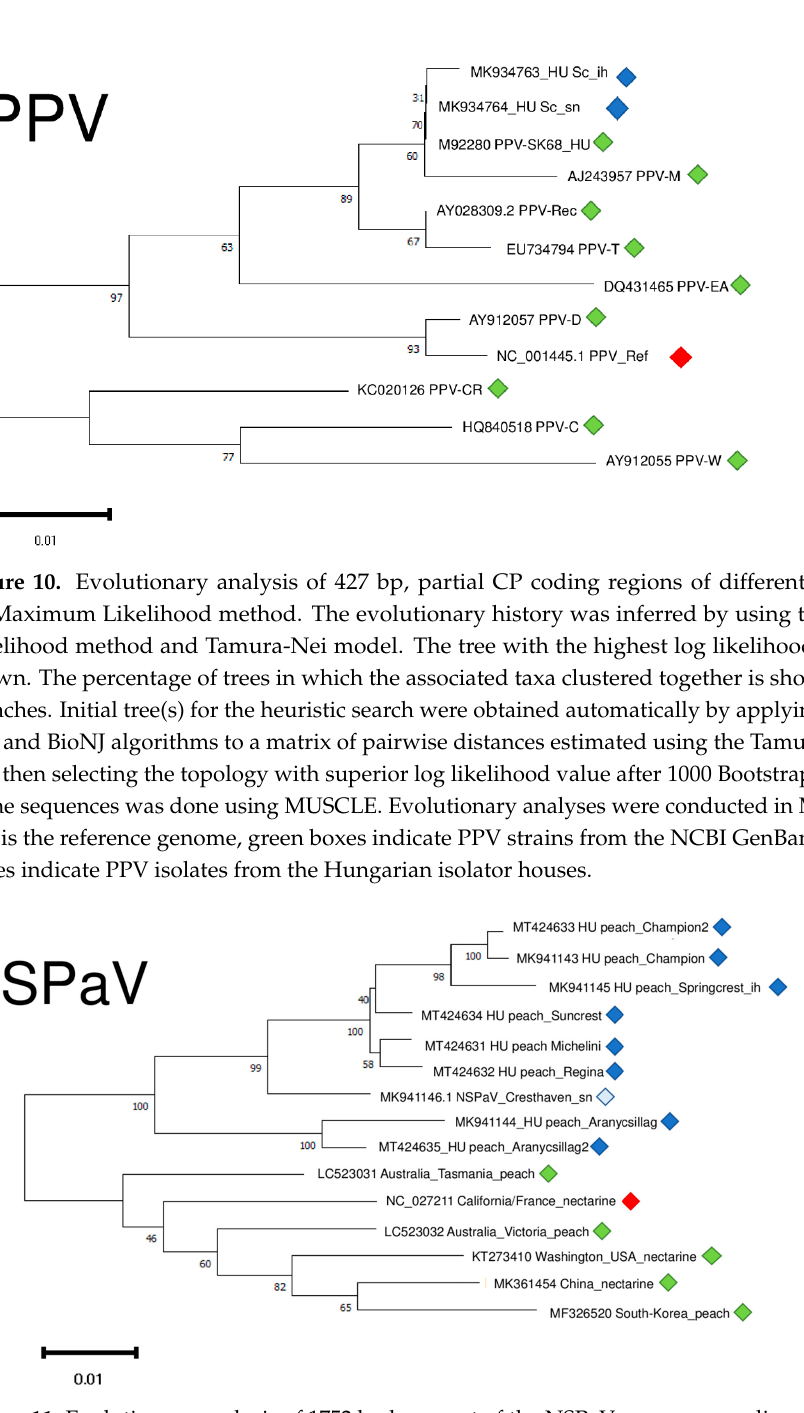
Figure 11. Evolutionary analysis of 1752 bp long part of the NSPaV genome encoding partial CP and readthrough protein of different NSPaV isolates by Maximum Likelihood method. The evolutionary history was inferred by using the Maximum Likelihood method and Tamura-Nei model. The tree with the highest log likelihood ( − 5007.67) is shown. The percentage of trees in which the associated taxa clustered together is shown below the branches. Initial tree(s) for the heuristic search were obtained automatically by applying Neighbour-Join and BioNJ algorithms to a matrix of pairwise distances estimated using the Tamura-Nei model, and then selecting the topology with superior log likelihood value after 1000 Bootstraps. Alignment of the sequences was done using MUSCLE. Evolutionary analyses were conducted in MEGA11. Red box is the reference genome, green boxes indicate NSPaV strains from the NCBI GenBank, Hungarian NSPaV strains are indicated with dark blue (originating from the isolator house), light blue (originating from the open field stock nursery).